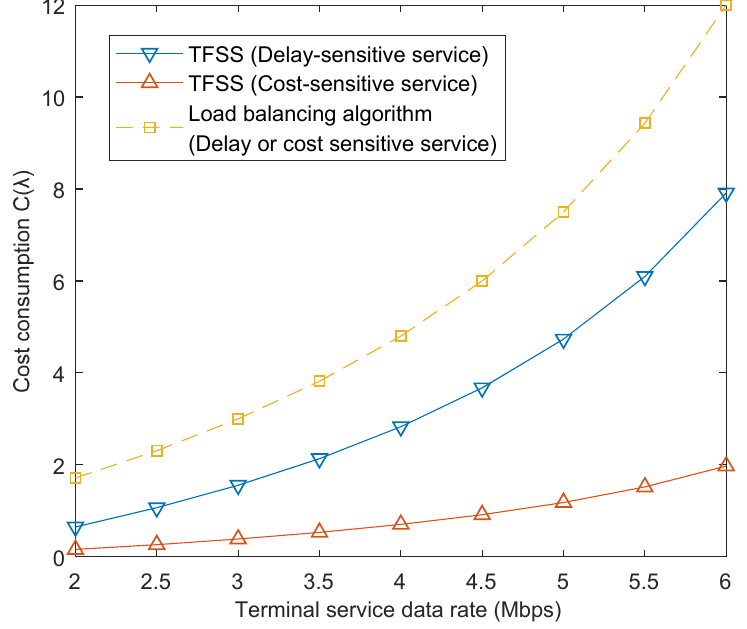
Figure 5. System delay comparison results.